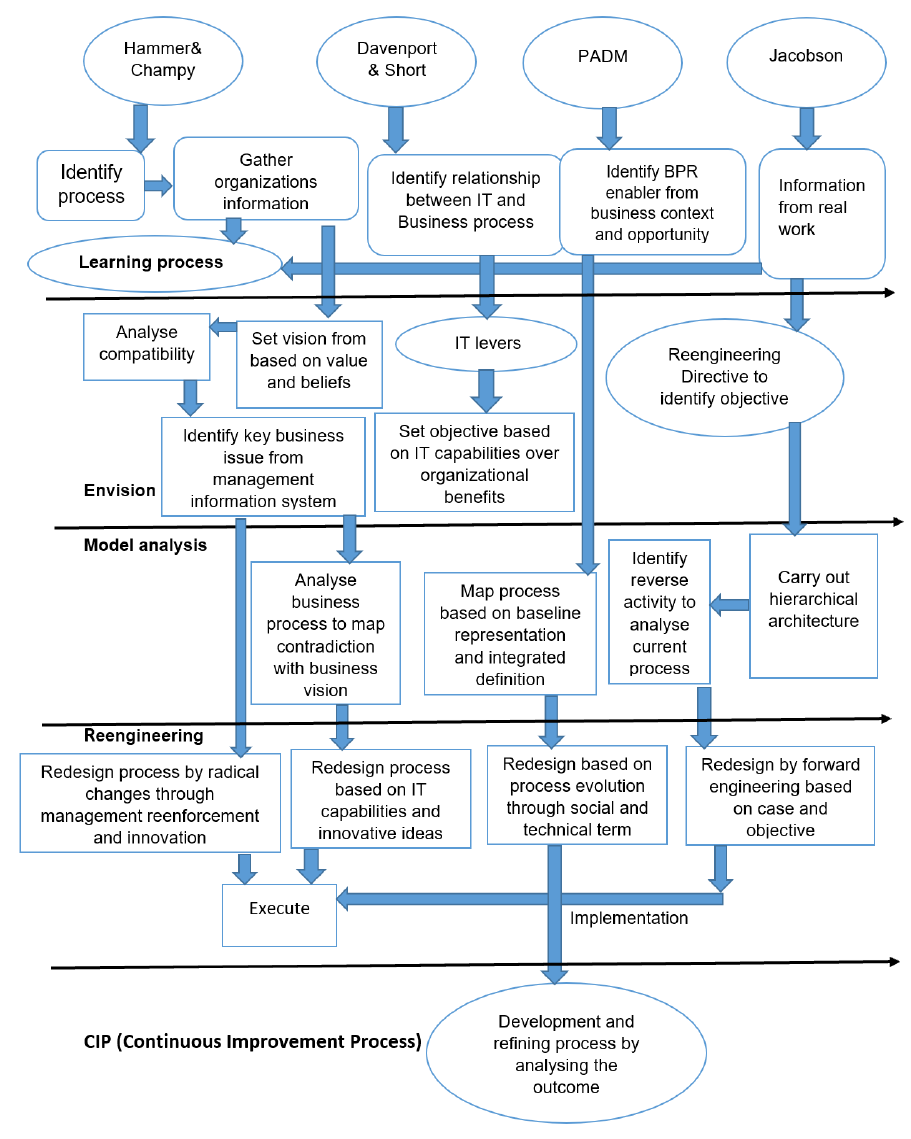
Figure 7. Framework of the BPR methodology implementation phase.